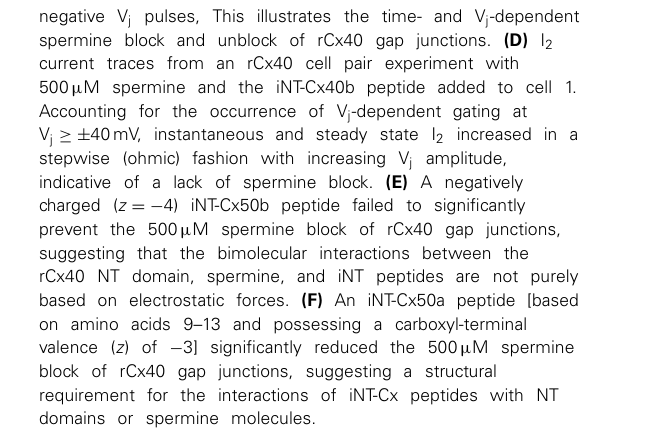
FIGURE 4 | (A) The sensitivity of four connexin-specific gap junctions was tested using the 2mM spermine block assay. Human Cx40 (hCx40, (cid:2) ) displayed similar V j -dependent sensitivity to spermine as rCx40 despite the N9 substitution. Cx37 ( (cid:2) ), Cx46 ( ◦ ), and Cx50 ( • ) gap junctions were all ≥ 60% inhibited by spermine. The maximum inhibition of Cx37 g j occurred at + 20mV, half the V j required for maximal block of any other known connexin-specific gap junction. (B)